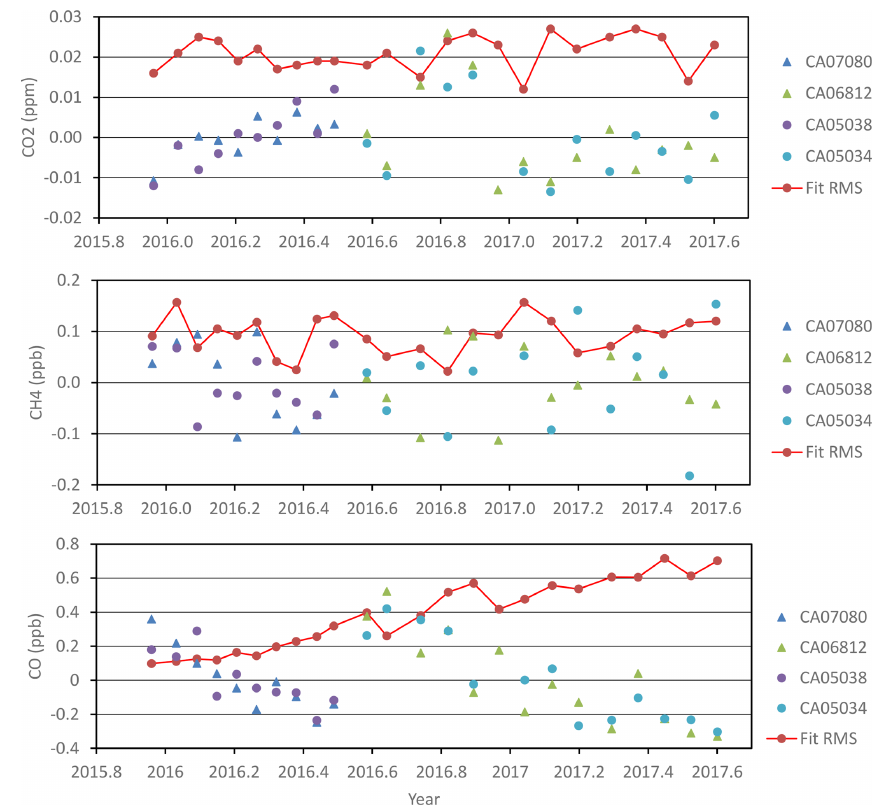
Figure 7. The rms residual of the fit (red dots/line) and the difference between the assigned mole fraction to a target gas and the mean mole fraction of such a target gas (a different color is used for each target gas), for each species and mole-fraction calibration performed using four WMO laboratory standards (every 3 or 4 weeks).